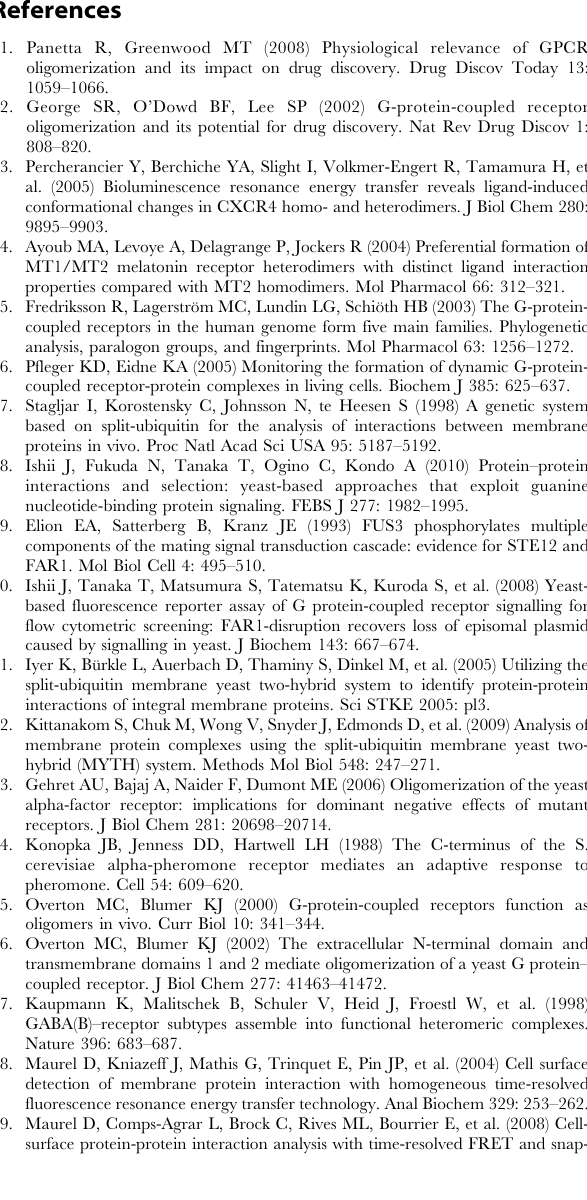
Table S3 List of prey GPCR library. (PDF) Document S1 Supplementary Materials and Methods (Plasmid constructions for supporting information)